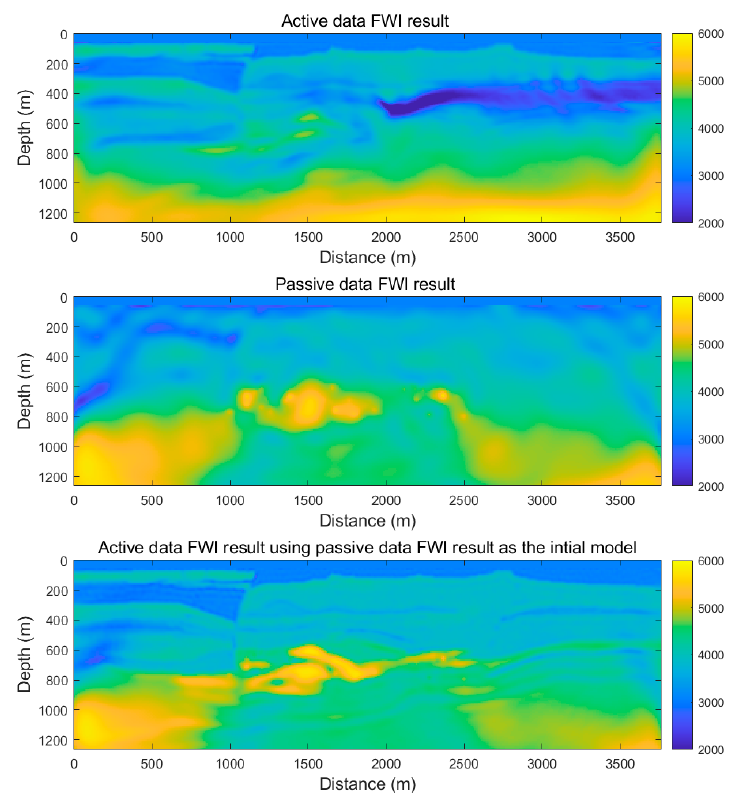
Figure 9. The conventional FWI result of the passive source data with noise.